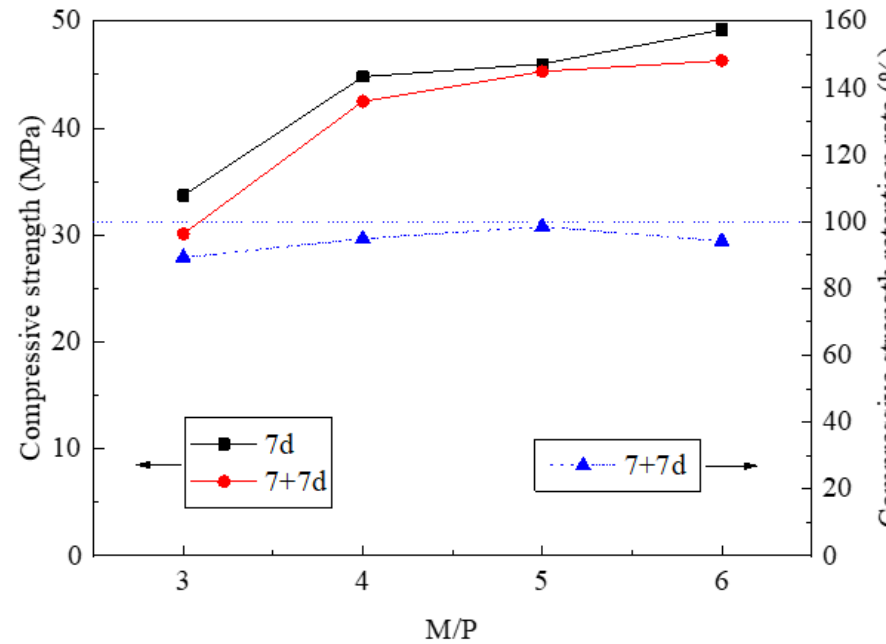
Figure 10. Compressive strength and its retention rate of HDMC with different M/P ratios.